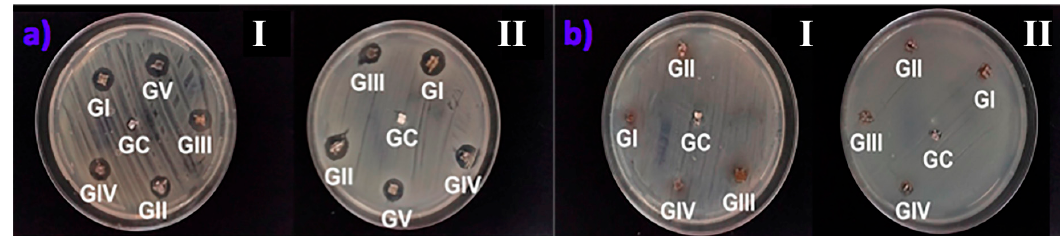
Figure 4. ( a ) Representative images of brackets without AgNPs (control group) and ( b ) brackets with AgNPs (experimental group) when evaluated in vitro with strains of Staphylococcus aureus ( I ) and Escherichia coli ( II ).